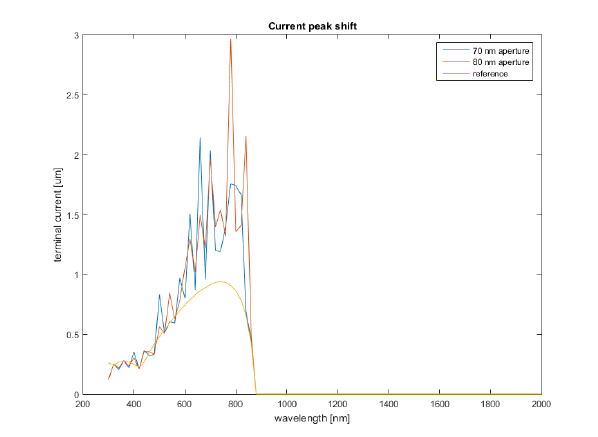
Figure 18. Current obtained on the layer’s terminal for each considered aperture